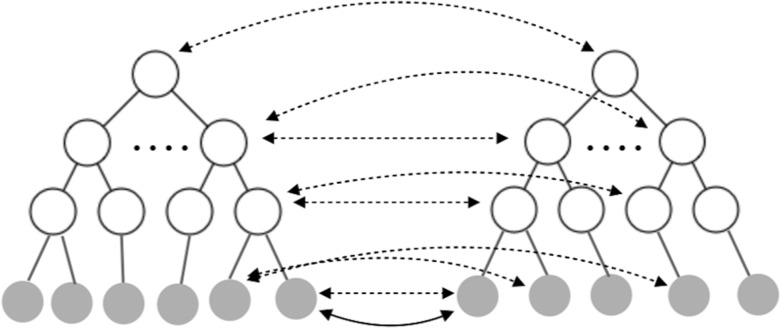
An illustration of the adaptive search between two octrees. Dotted lines point out the possible cube pairs on each level that pass the Necessary Condition 1. Solid lines link the desirable leaf cube (gray nodes) pairs that pass the Sufficient Condition 2.